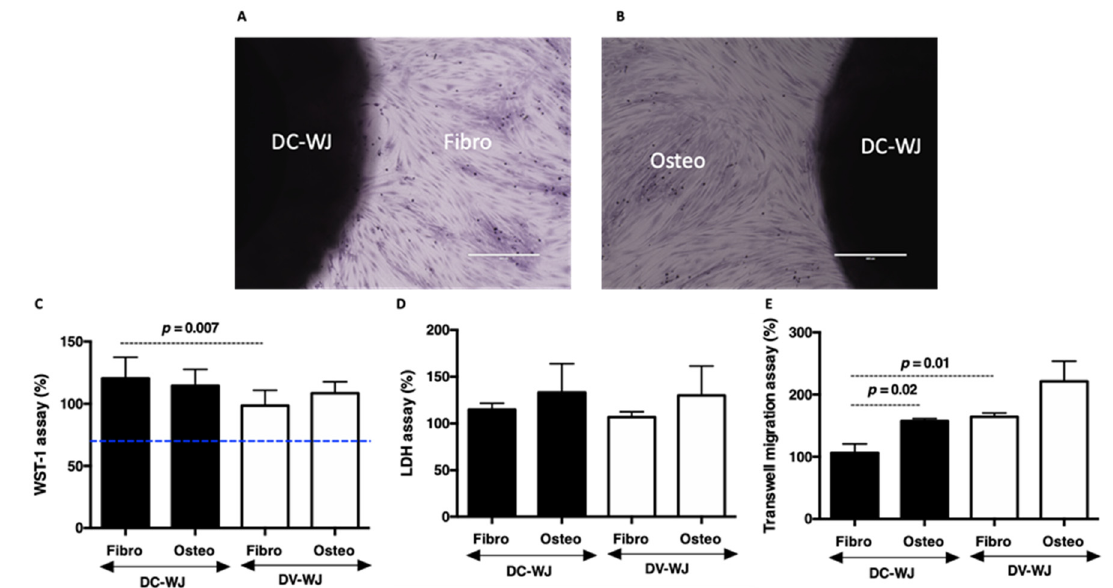
Figure 2. Biocompatibility of decellularized Wharton’s Jelly. ( A , B ): Pictures showing respectively crystal violet labelled fibroblasts (Fibro) and osteoblast (Osteo) growing in the presence of DC-WJ (scale bars = 400 µm). ( C , D ): Histograms reflecting percentage of cell viability and LDH release by damaged cells, respectively. Blue line indicates the threshold considered as an indicator of cytotoxic phenomenon, according to ISO standard (ISO/EN 10,993 part 5 guidelines), highlighting the absence of cytotoxic agents in both samples. ( E ): Transwell chemotaxis assay, showing a significant increase in fibroblast migration in the presence of DV-WJ compared DC-WJ ( n = 6, Wilcoxon-Mann-Whitney test).